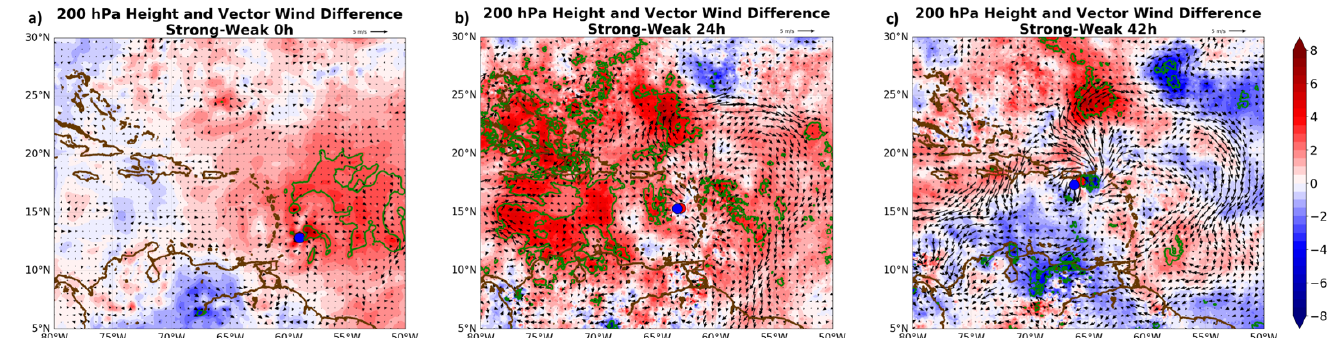
Figure 6. ( a ) 200-hPa height difference (m, shaded) between the composite of the 20 strongest members and 20 weakest members (based on minimum pressure at 42 h) at 0 h (initialization). The green contours highlight areas that have a statistically significant difference ( p < 0.05). The vectors show the difference in the composite vector winds between the strong and weak groups. The red and blue circles show the mean positions of the strong and weak groups. ( b ) As in ( a ), but for the 24 h forecast. ( c ) As in ( b ), but for the 42 h forecast.